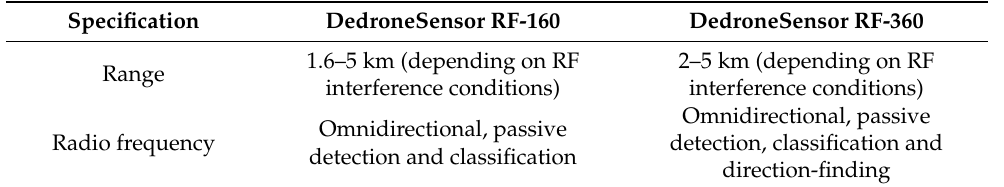
Table 7. DedroneSensor’s RF sensors’